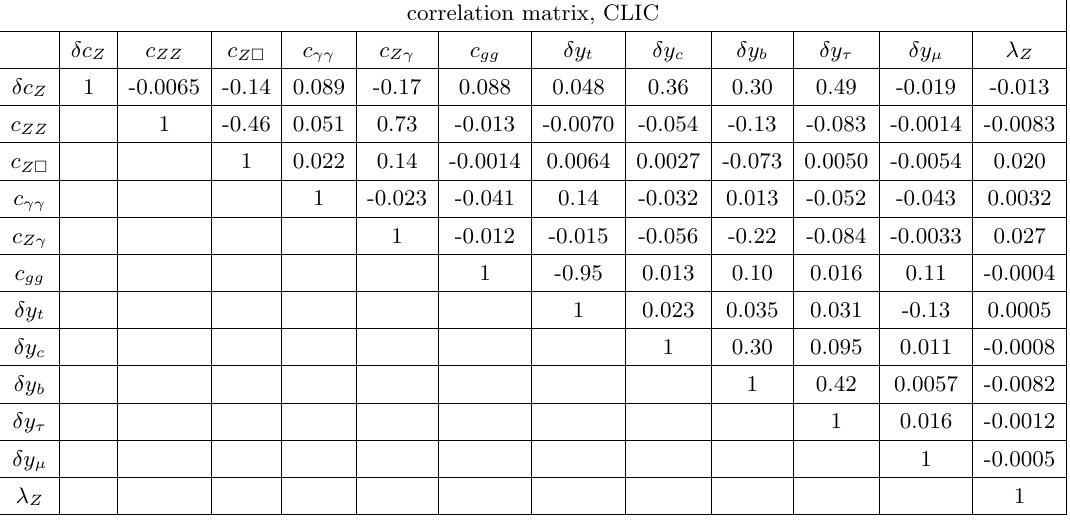
Table 15 . The corresponding correlation matrix for the CLIC one sigma bounds in table 11. Open